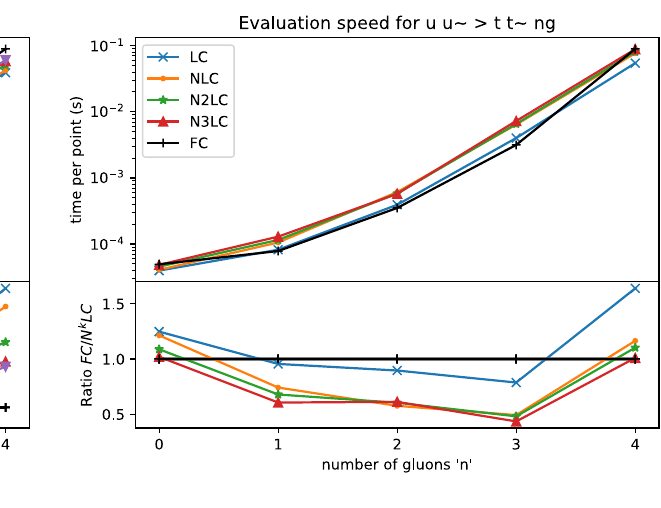
Fig. 12 Same as Fig. 10 but for u ¯ u → d ¯ d + ng (left) and u ¯ u → u ¯ u + ng (right)